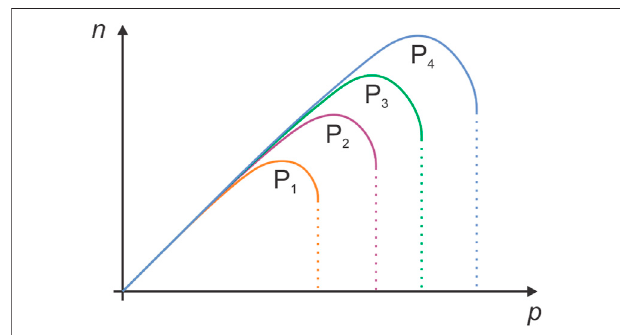
FIGURE 2 | The density of neutral reactive plasma species versus pressure in the discharge chamber. The parameter is the discharge power with P 1 < P 2 < P 3 < P 4